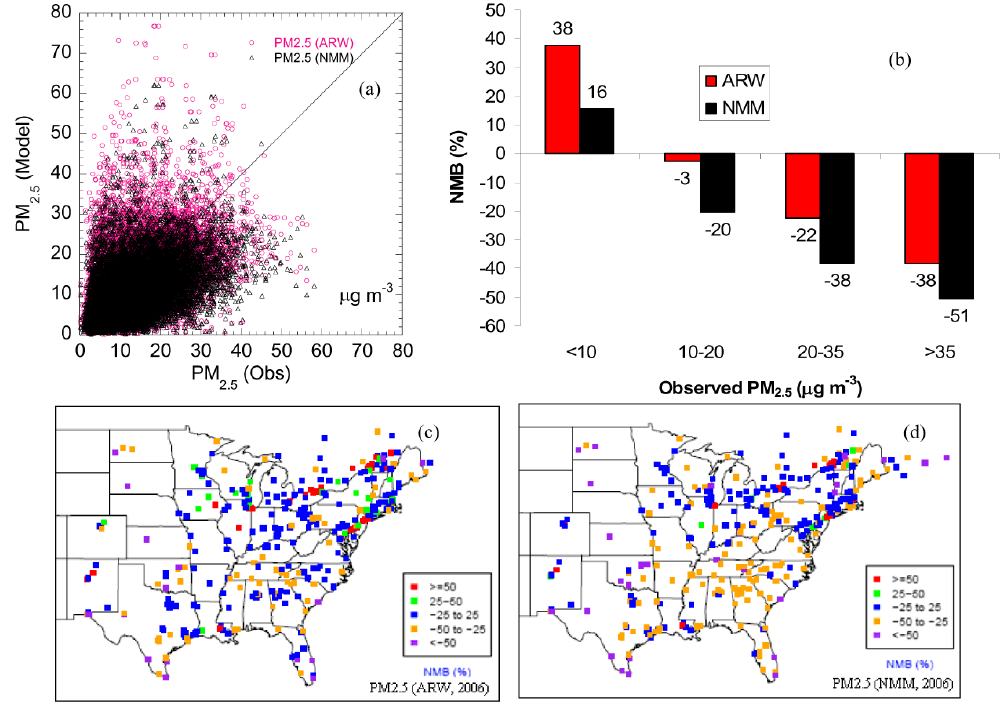
Fig. 1. Comparison of the modeled (ARW-CMAQ, NMM-CMAQ) and observed daily PM 2 . 5 concentrations at the AIRNow monitoring sites (a) scatterplot (ppbv); (d) The NMB values of each model as a function of the observed daily PM 2 . 5 concentration ranges; spatial distributions of NMB for (c) ARW-CMAQ and (d) NMM-CMAQ during the period 5 August and 7 October 2006.